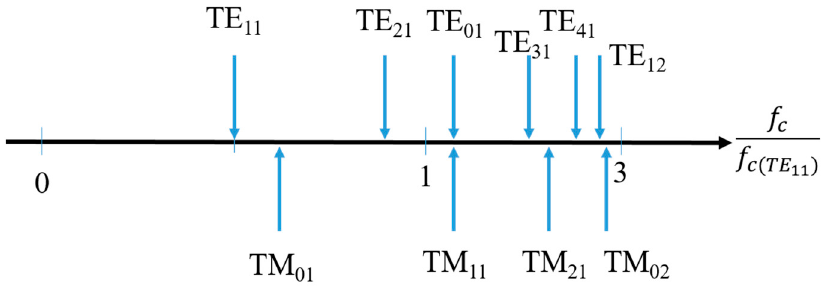
Figure 11. Mode series for the circular waveguide.